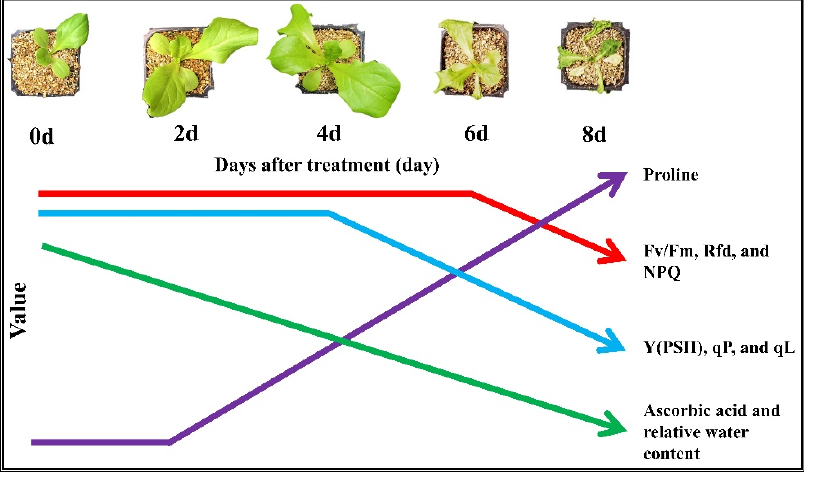
Figure 7. Schematic diagram of the changes of major parameters during progressive treatment time under drought stress condition. Refer to the Table 1 for detailed information of CF parameters. Supplementary Materials: The following are available online at www.mdpi.com/xxx/s1, Table S1: Growth parameter of lettuce seedling as affected by drought stress during the experiment, Table S2: Changes in chlorophyll fluorescence parameters measured for lettuce seedlings as af- fected by drought stress during progressive treatment time, Table S3: Summary of analysis of variance of chlorophyll fluorescence (CF) parameters in lettuce seedlings at the drought stress and treatment time.